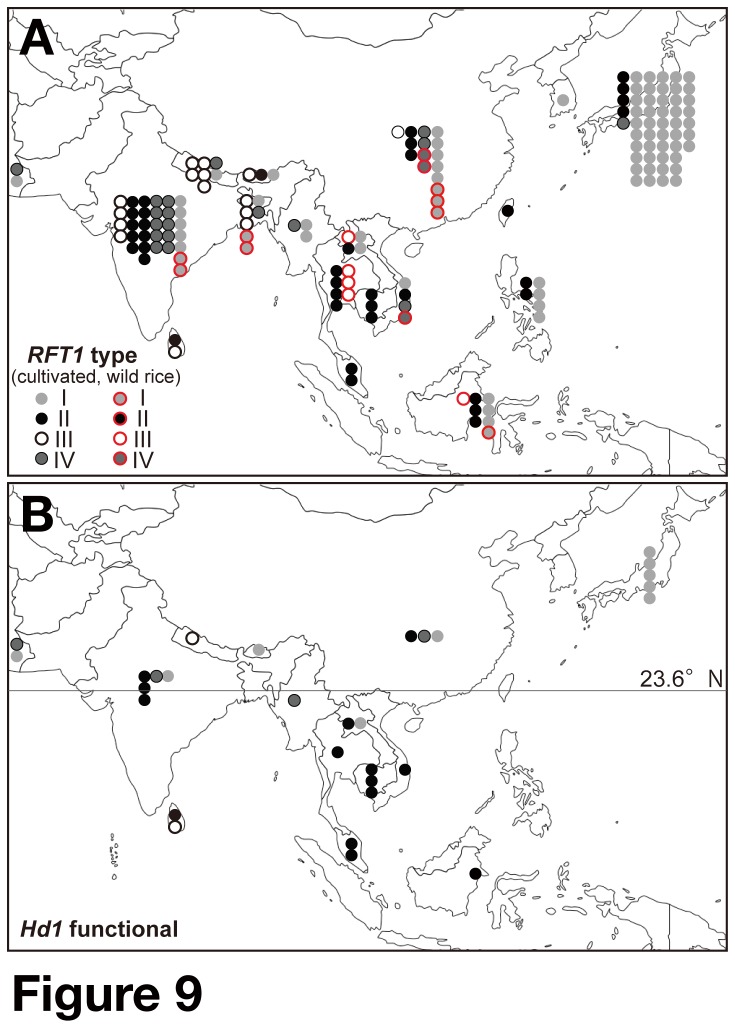
Geographic distribution of rice accessions and RFT1 haplotype groups.(A) Distribution and RFT1 haplotypes of 143 O. sativa and 16

O

. rufipogon
 accessions. (B) The subset containing only accessions with functional Hd1. Black line indicates 23.6° north latitude. To the south of this line, maximum daylength is less than 13 h.